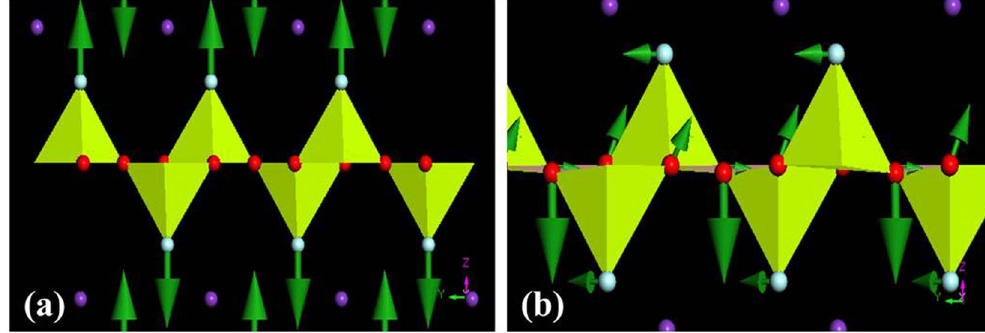
Figure 9. The stretching mode A ( a ) and twisting mode a ( b ) are shown for flux-KBBF at 4 GPa